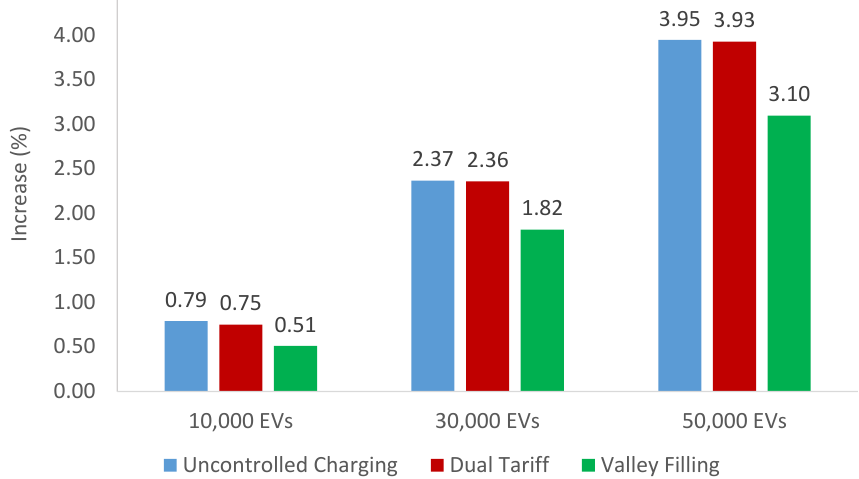
Figure 13. Generation CO 2 footprint in Crete, considering different charging schemes [16].